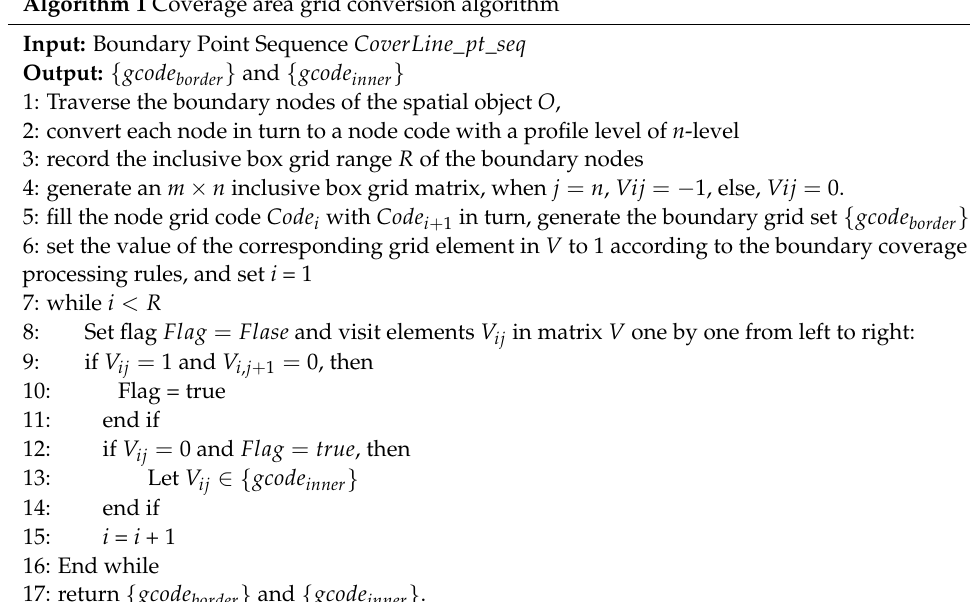
Algorithm 1 Coverage area grid conversion